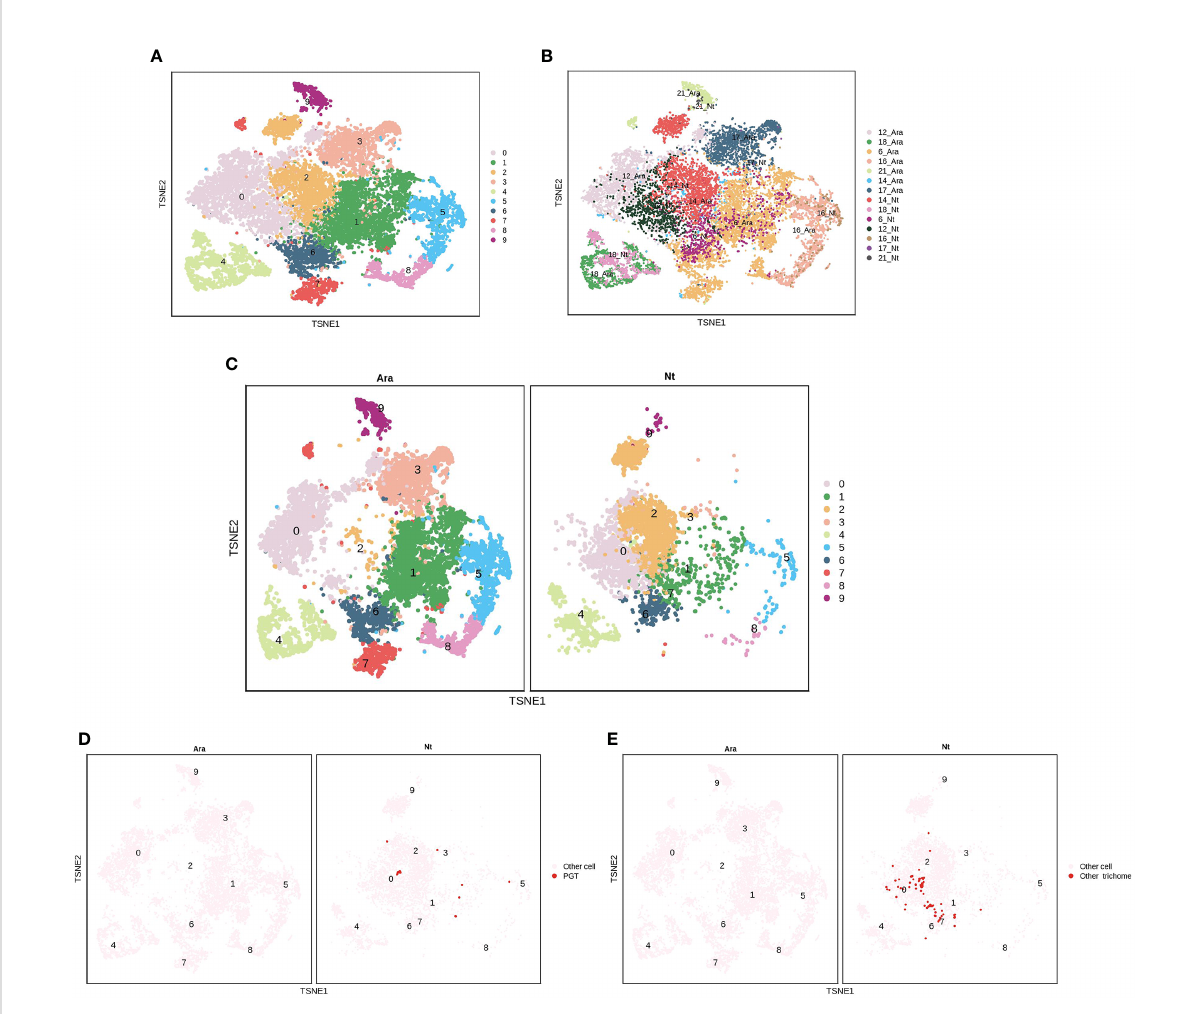
FIGURE 6 Comparison of the epidermis cells of N. tenuifolia and Arabidopsis. (A) The merged epidermis cells of N. tenuifolia and Arabidopsis; (B) The merged epidermis cells of N. tenuifolia and Arabidopsis noted by P6, P12, P14, P16, P17, P21; (C) Divided t-SNE of merged epidermis cells; (D) The distribution of E12 (PGT) cells in merged t-SNE of epidermis cells; (E) The distribution of E9 (other trichomes) cells in merged t-SNE of epidermis